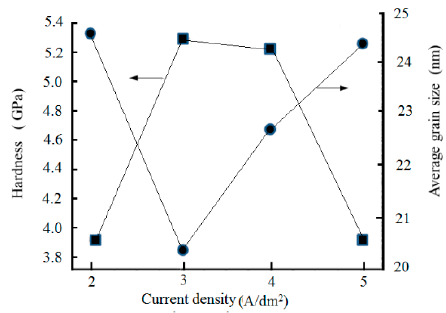
Figure 13. Relationship curve between current density and the grain size and hardness of the composite coating.